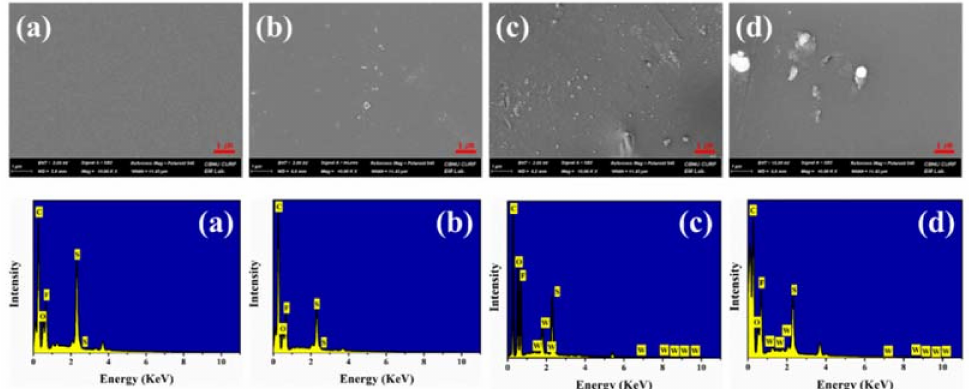
Figure 6. The SEM micrographs and EDX spectrum of SPAE composite membranes: ( a ) SPAE pristine membrane, ( b ) SPAE/GO, ( c ) SPAE/GO/PWA 12 wt%, ( d ) SPAE/GO/PWA 36 wt%. Note that the scale bar for all images is 1 µ m.